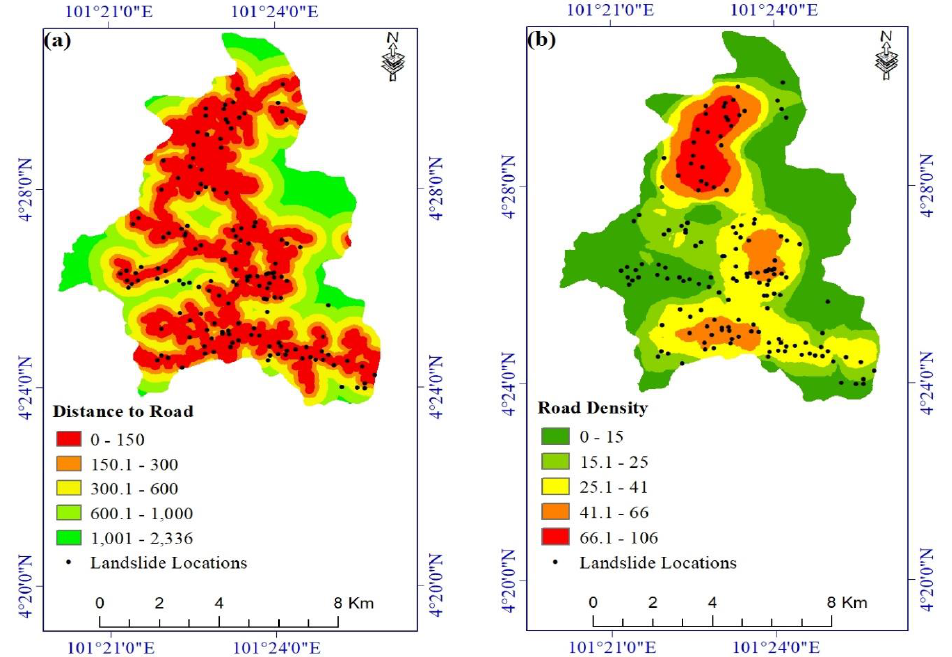
Figure 7. Landslide conditioning factors: ( a ) distance to road and ( b ) road density.